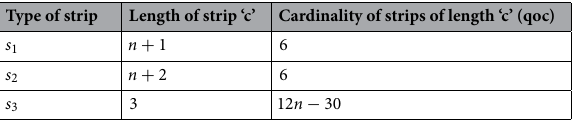
Table 2. Partition of Kekulenes